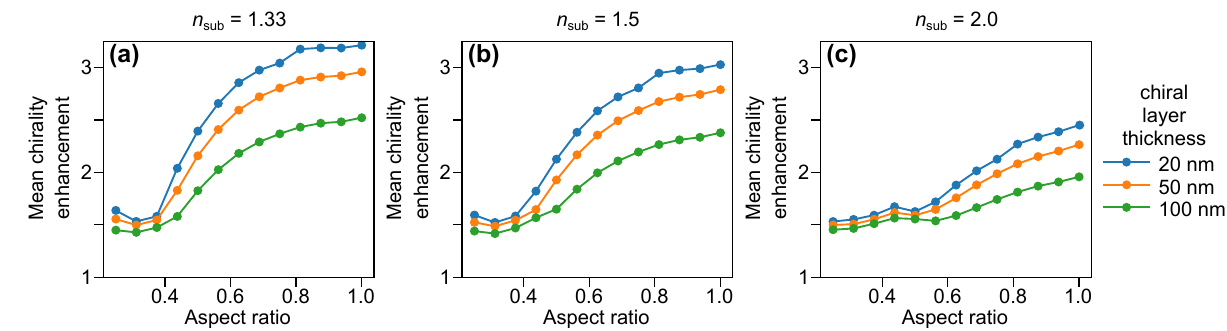
Figure 7: Mean chirality enhancement in thin layers (thickness from 20 to 100 nm) surrounding the nanodisk using the reflection = n , (b) glass with n = 1.5, and (c) high-index dielectric n = 2. It is clear that a substrate is configuration. (a) Disk embedded in water n sub env detrimental to the device performance, while the dependence on AR is always close to that obtained by surface